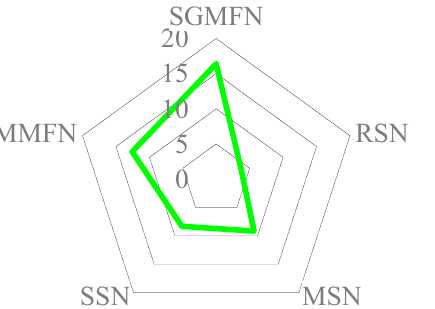
Figure 12. Comparison results of framerate of different network models.